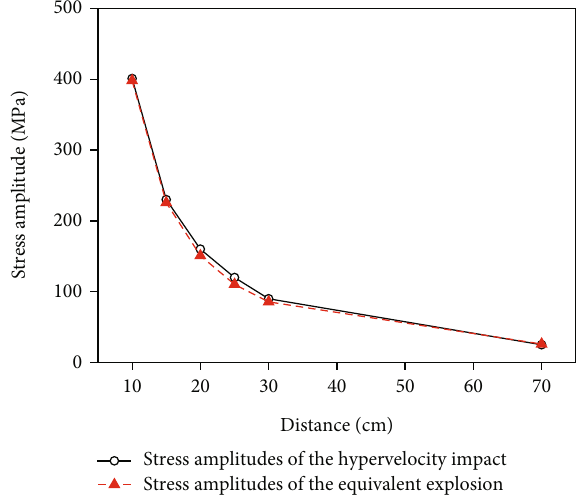
Figure 12: Stress attenuation curves of the hypervelocity impact and the equivalent